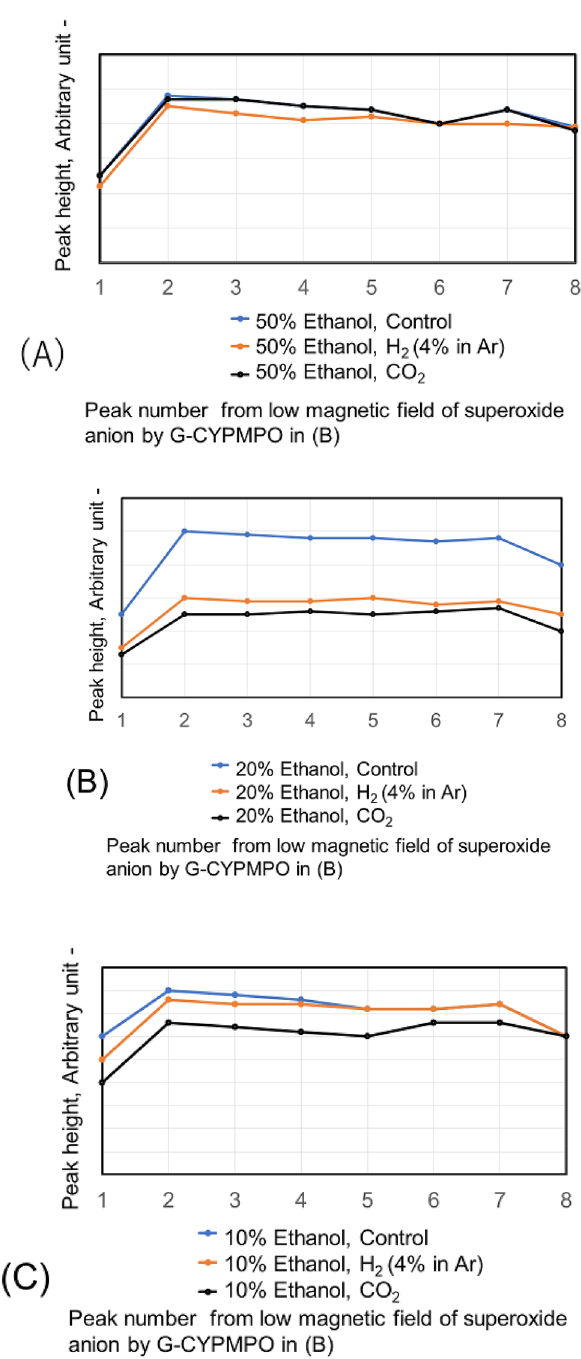
Figure 9. Peaks of superoxide anion radical with ESR in 10, 20, and 50% ethanol aqueous solution containing